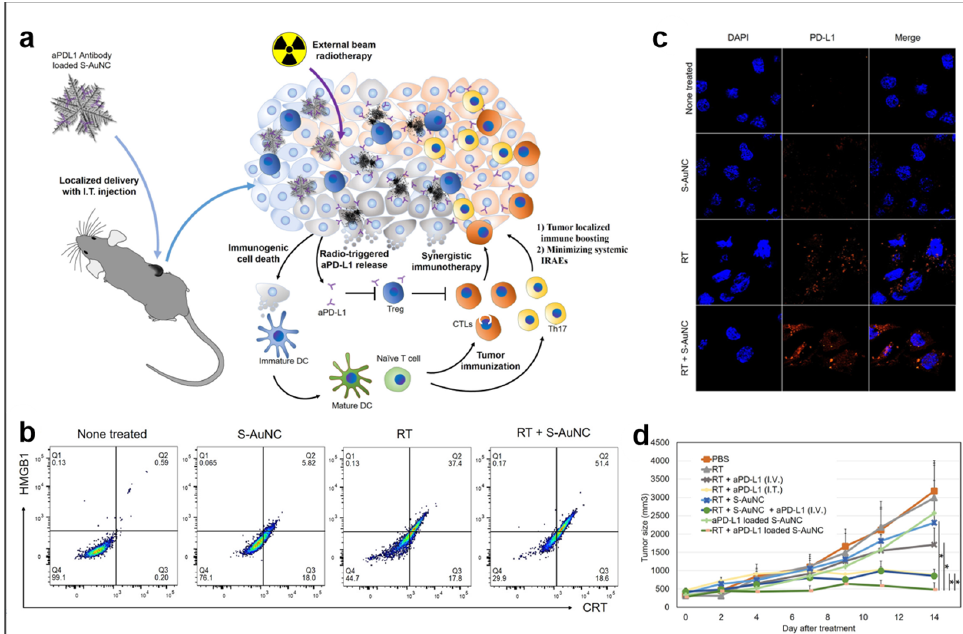
Figure 9. BMNs used in cancer radiotherapy. Reprinted with permission from Ref. [119]. ( a ) Schematic illustration of the radiation using radiation − responsive splintery metallic nanocarriers. ( b ) The ICD population of the group treated with S − AuNC, RT, and RT + S − AuNC. ( c ) Enhanced PD − L1 expression of Tramp C1 in response to the radiosensitization with S − AuNC. ( d ) Tumor growth graph. Copyright © 2020 American Chemical Society. * p <